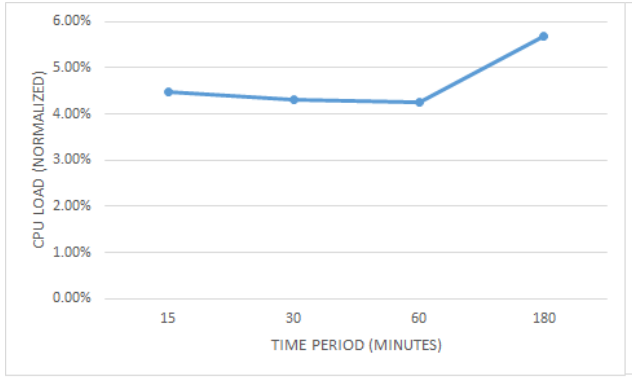
Figure 9. AndroCon CPU Load